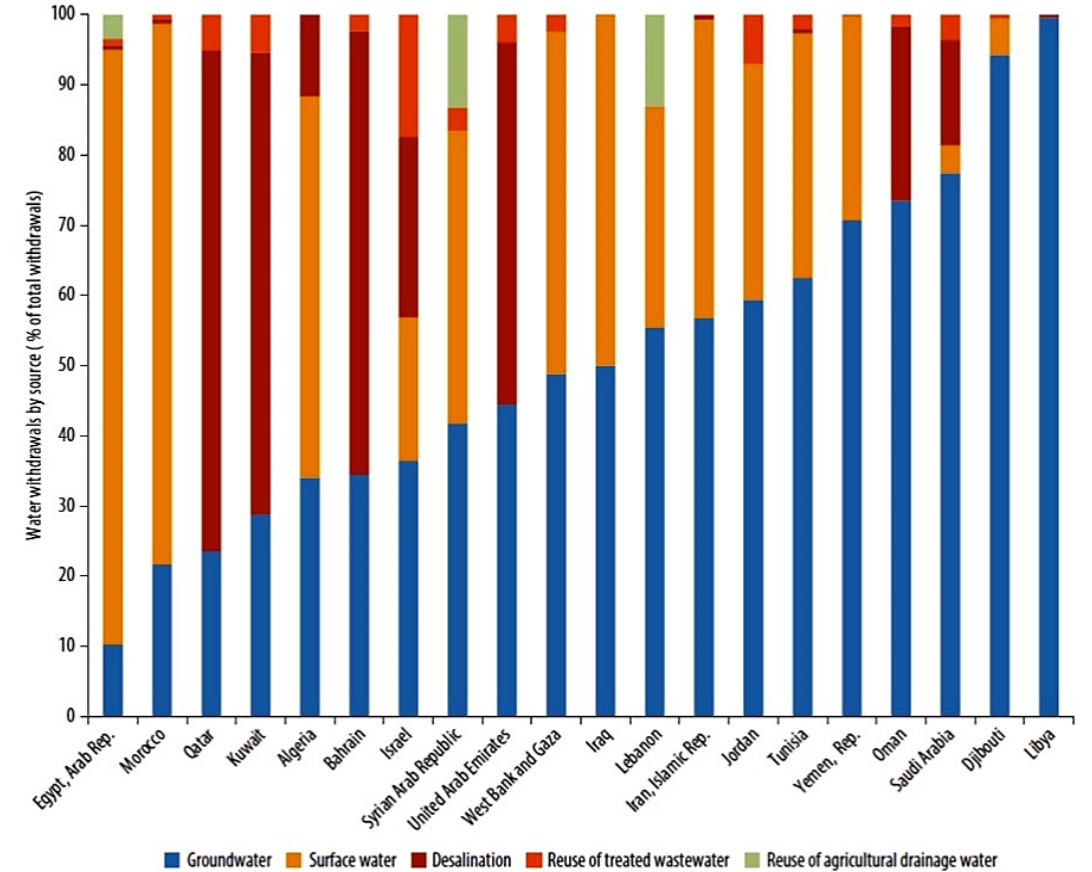
Figure 7. Water withdrawals in MENA countries, by source, as a percentage of total withdrawals, by country and economy, 2010 ; source: [12] .